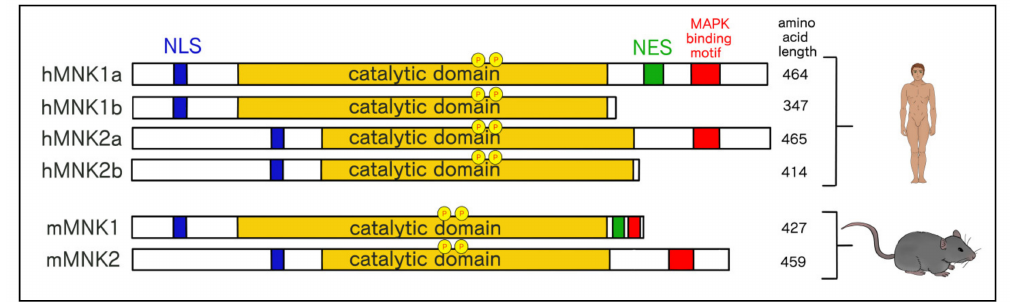
Figure 2. Schematic representation of the core features of human and murine mitogen activated protein kinase-interacting kinases 1 and 2 (MNK1 and MNK2). In humans, MNK1 and MNK2 are spliced into ”a” and “b” isoforms whereas in mice MNK1 and MNK2 are not spliced. NLS, nuclear localization signal; NES, nuclear export